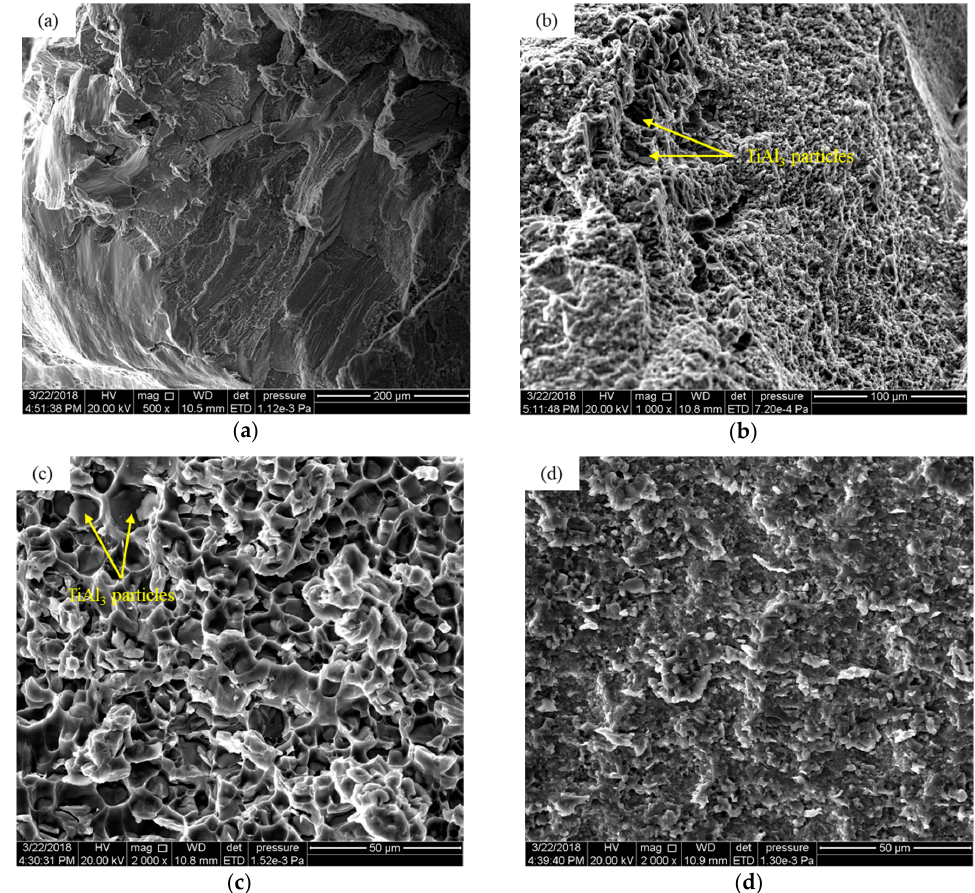
Figure 8. Highlighting the details of the fracture surface of each region marked with the red square in Figure 7b: ( a ) region I; ( b ) region II; ( c ) region III; and ( d ) region IV. Figure 7b: ( a ) region I; ( b ) region II; ( c ) region III; and ( d ) region